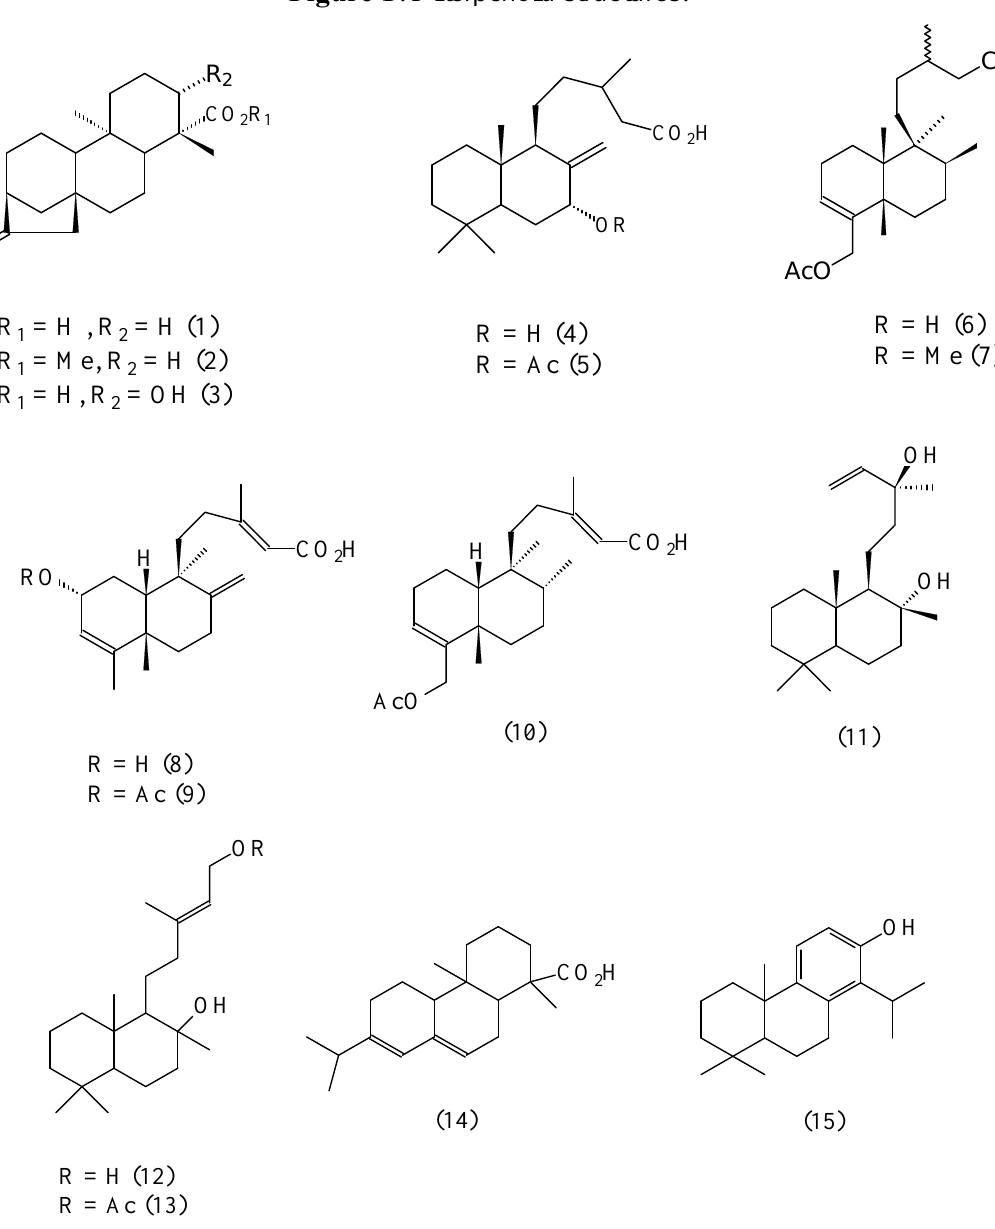
Figure 1 . Diterpenoid